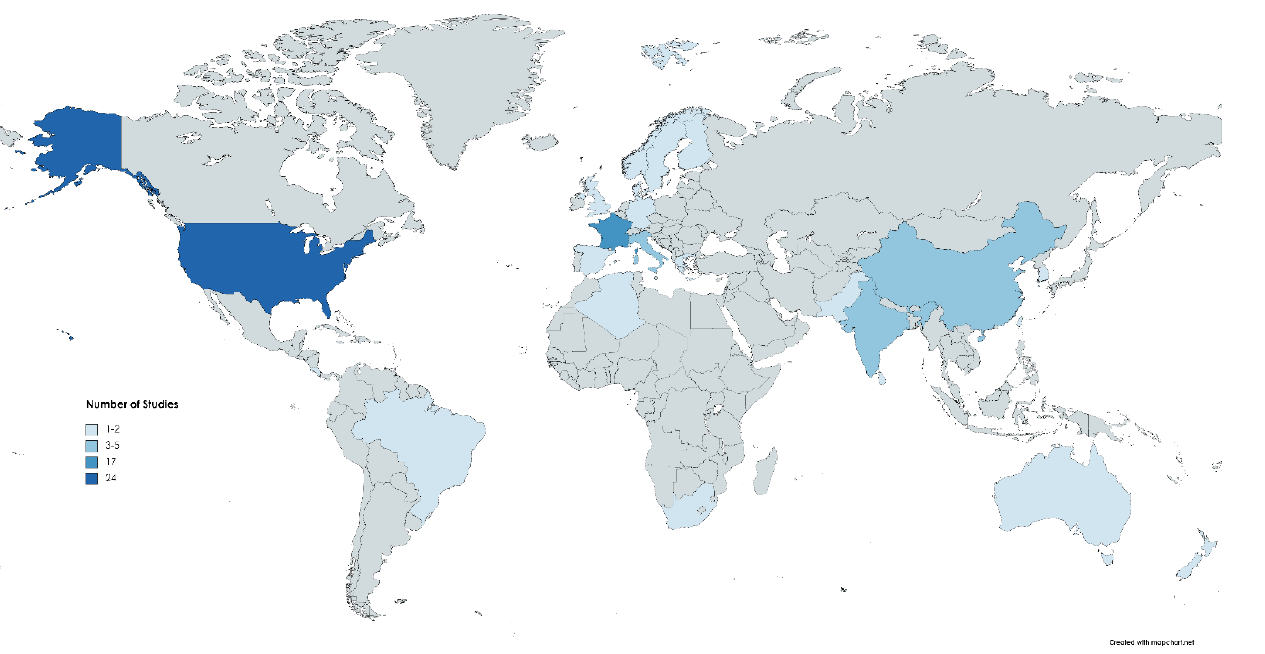
Figure 2. Number of agricultural workers’ brain health studies published by country not including animal studies or international studies.